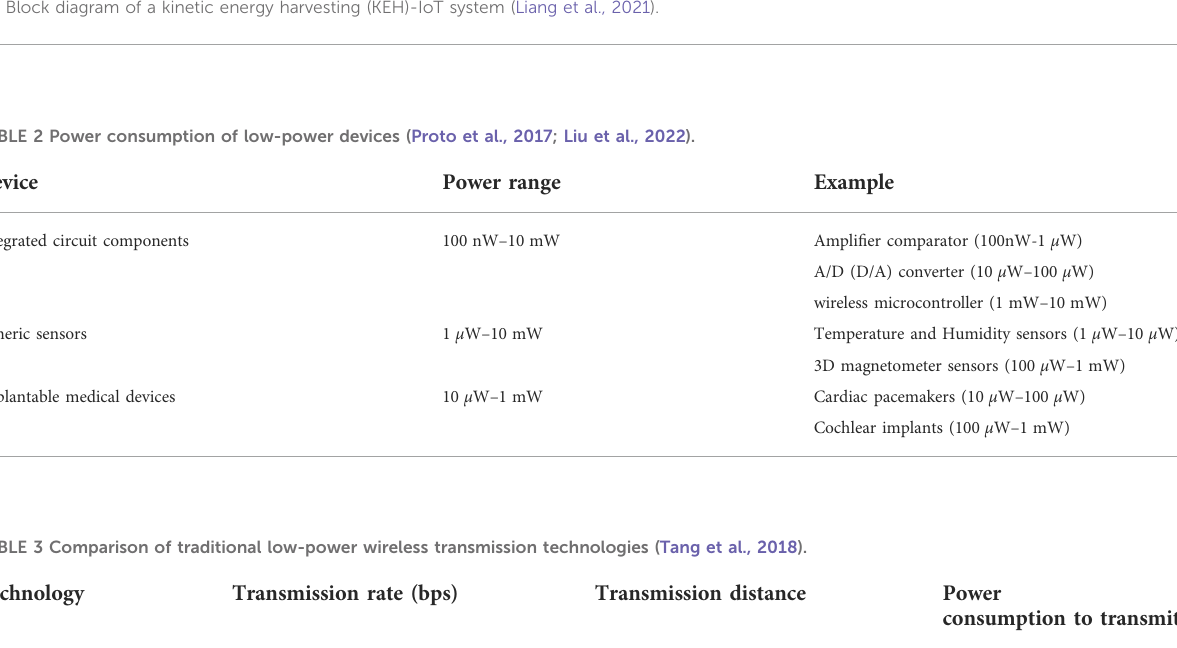
FIGURE 8 Block diagram of a kinetic energy harvesting (KEH)-IoT system (Liang et al., 2021).